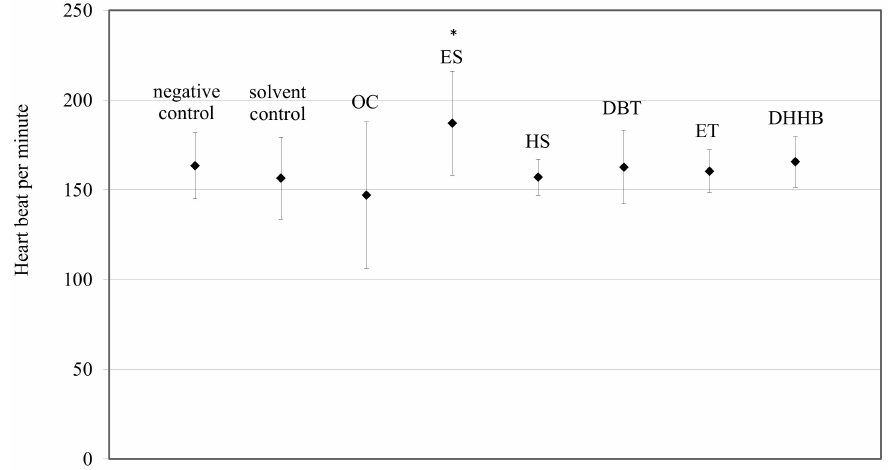
Figure 1. Cardiac frequency of 5 dpf larvae zebrafish ( Danio rerio ) exposed to one of the following treatments: controls, and exposure to OC, ES, HS, DBT, ET, or DHHB. Mean values ± standard deviation are plotted; * indicates a significant difference from the solvent control experiment ( t -test, p <